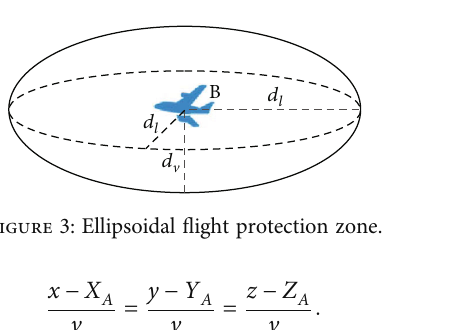
Figure 1: Position detection area.